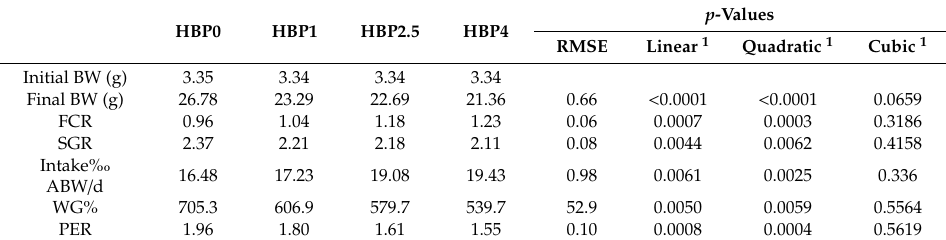
Table 4. Growth performance of meagre fed experimental